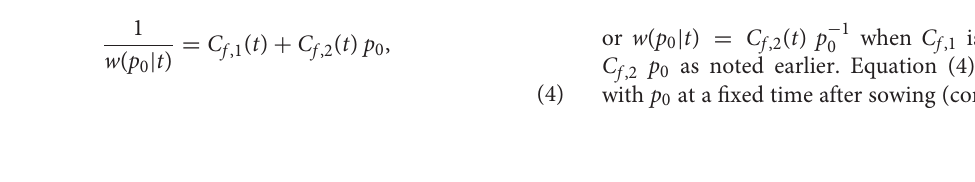
Frontiers in Forests and Global Change | www.frontiersin.org